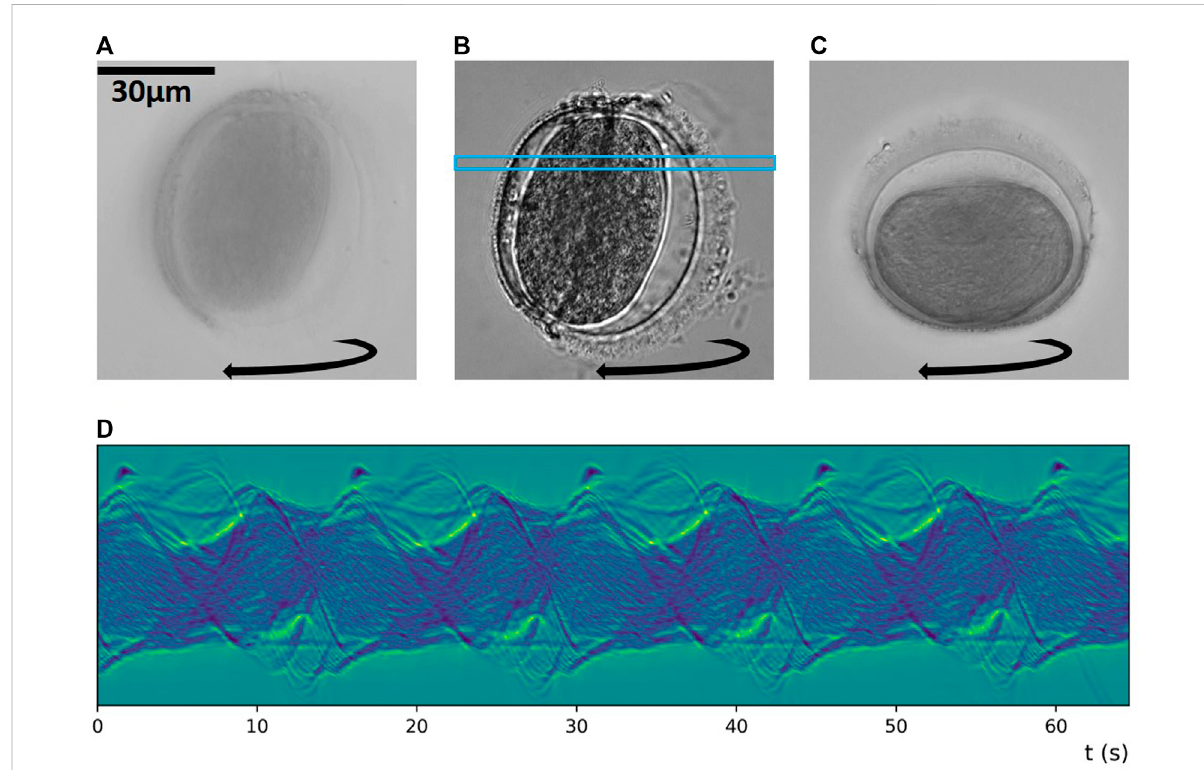
FIGURE 6 Sustained rotation and high-NA imaging and illumination: There is a trade-off between (A) the highest resolution at NA obj + NA con = 2.3 and (B) the highest contrast at NA obj + NA con = 1.3. Around NA obj + NA con = 1.75 as in (C) one gets a good compromise between good resolution and good contrast. The particle in (A,B) rotates around an object axis orthogonal to the one in (C) . (D) provides a MIP-based sinogram pertaining to the blue rectangle in (B) . Corresponding Supplementary Movies S5 – S7.